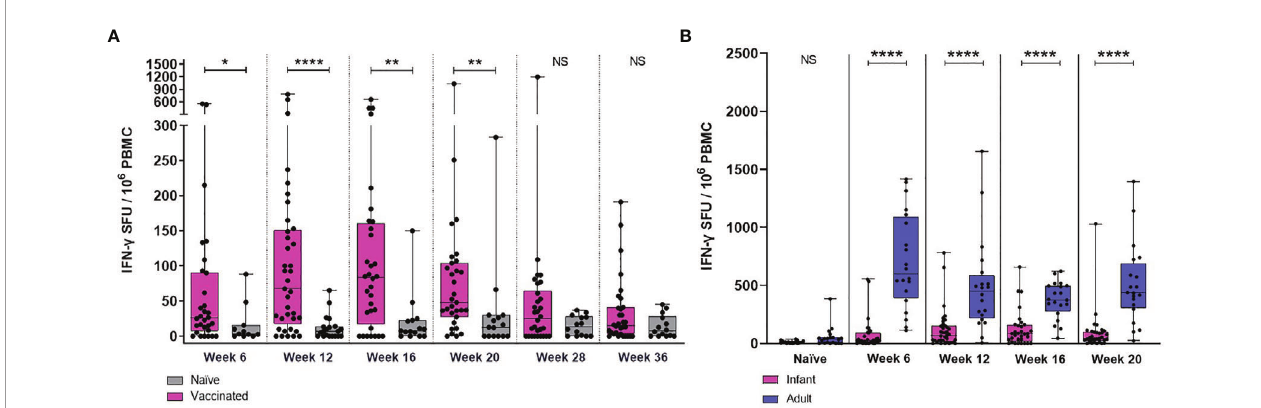
FIGURE 2 | PPD-speci fi c IFN- g spot forming unit (SFU) frequency measured by ELISPOT following ID BCG vaccination. (A) IFN- g -speci fi c SFU from BCG vaccinated macaques and unvaccinated macaques during the initial 36 weeks after vaccination. (B) IFN- g -speci fi c SFU from BCG vaccinated infant (pink) and young adult (blue) macaques during the fi rst 20 weeks after vaccination. Box plots show the group median +/- the inter-quartile range measured at each time point after vaccination, with minimum and maximum values connected by whiskers. Signi fi cant differences measured by Mann-Whitney U-test between the groups are indicated. *p ≤ 0.05, **p < 0.01, ****p < 0.0001, NS, not signi fi cant. n=39 for BCG vaccinated (pink), n=20 for unvaccinated controls (grey) and n=19 for young adults